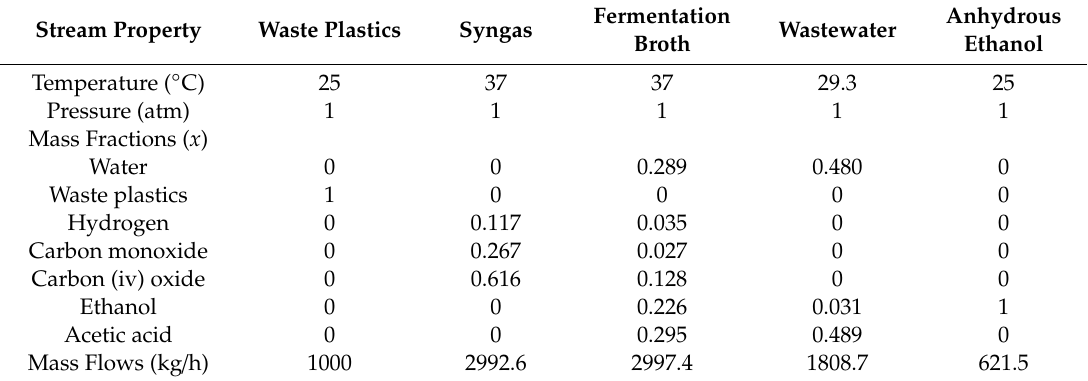
Table 2. Mass balance results for major streams in scenario i.